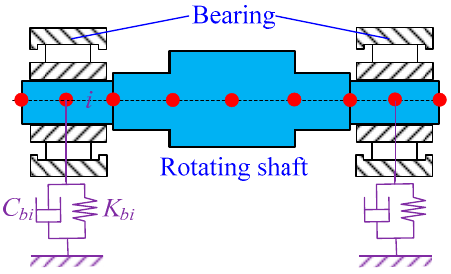
Figure 7. Bearing element.